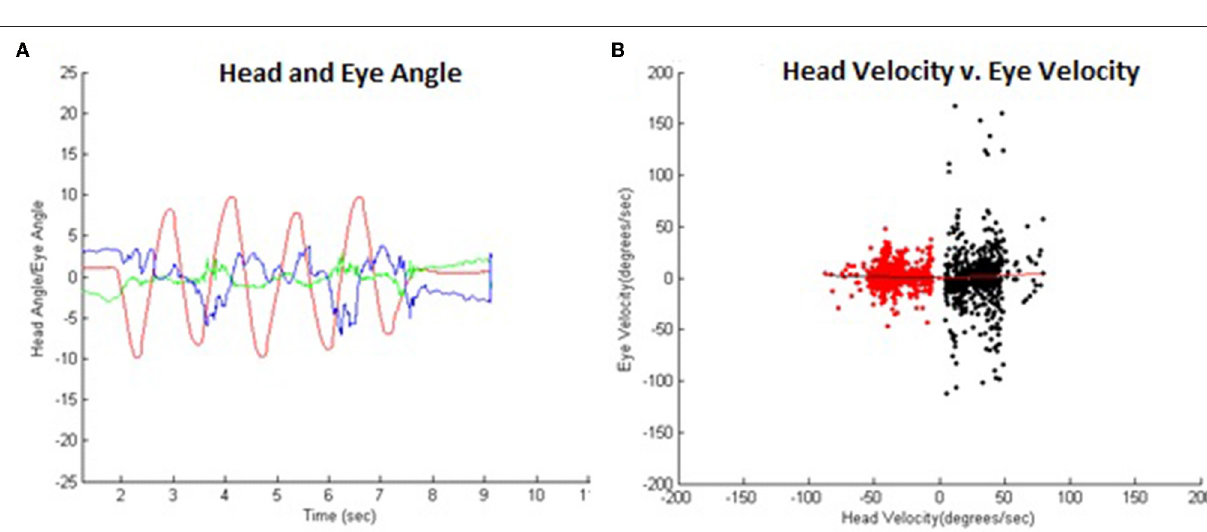
FIGURE 2 | (A) Typical example of VOR temporal head (blue) and eye (green) angle data. (B) These same data comparing head vs. eye angular velocity illustrating VOR. Leftward (black) and rightward head movements (red) are separated for analysis with head velocities below 5 ◦ /s excluded since the VOR response is negligible at low head velocities. The VOR gain was ∼ -0.8 in this example.